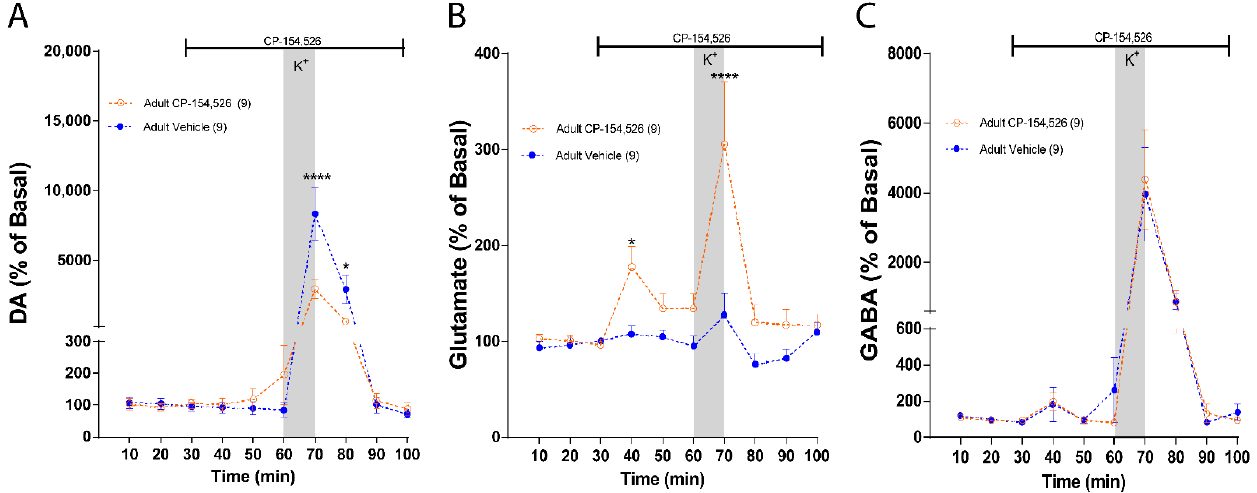
Figure 2. CRF-R1 modulates neurotransmitter levels in NAc of adult rats. Measurement of NAc extracellular neurotransmitter levels using in vivo microdialysis, the vertical gray bars indicate the time of NAc local infusion of 70 mM K+-aCSF, and the horizontal black lines indicate the time of intra-NAc infusion of the antagonist or vehicle. ( A ) NAc DA levels in the presence of aCSF (blue; n = 9) and 10 µM of CP154,526 (orange; n = 9). DA levels were normalized to the average of the first 3 values for each condition and expressed as percentage. Two-way ANOVA revealed a main effect of treatment (F (1, 8) = 6.258, p = 0.0369), a main effect of time (F (9, 72) = 28.51, p < 0.0001), and treatment × time interaction (F (9, 72) = 6.401, p < 0.0001; **** p < 0.0001, * p =0.0210, CP154,526 vs. aCSF, Bon- ferroni post hoc test). ( B ) NAc glutamate levels in the presence of aCSF ( n = 9) and 10 µM of